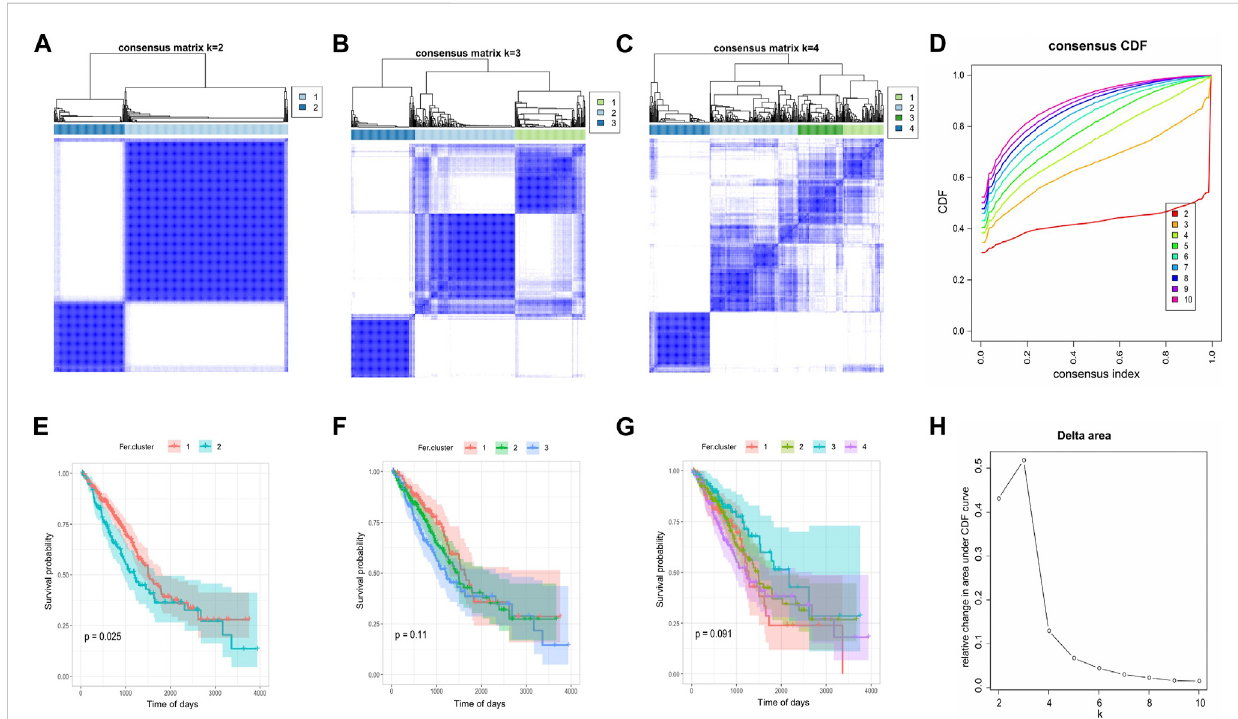
FIGURE 3 Consensus clustering of tumor ferroptosis-related genes expression pro fi les. (A – C) The clustering results when consensus matrix k = 2, k = 3, and k = 4. (D) Distribution of CDF curve of consensus clustering. (E – G) Survival curve when consensus matrix k = 2, k = 3, and k = 4, respectively. (H) Distribution of area under the CDF curve of consensus